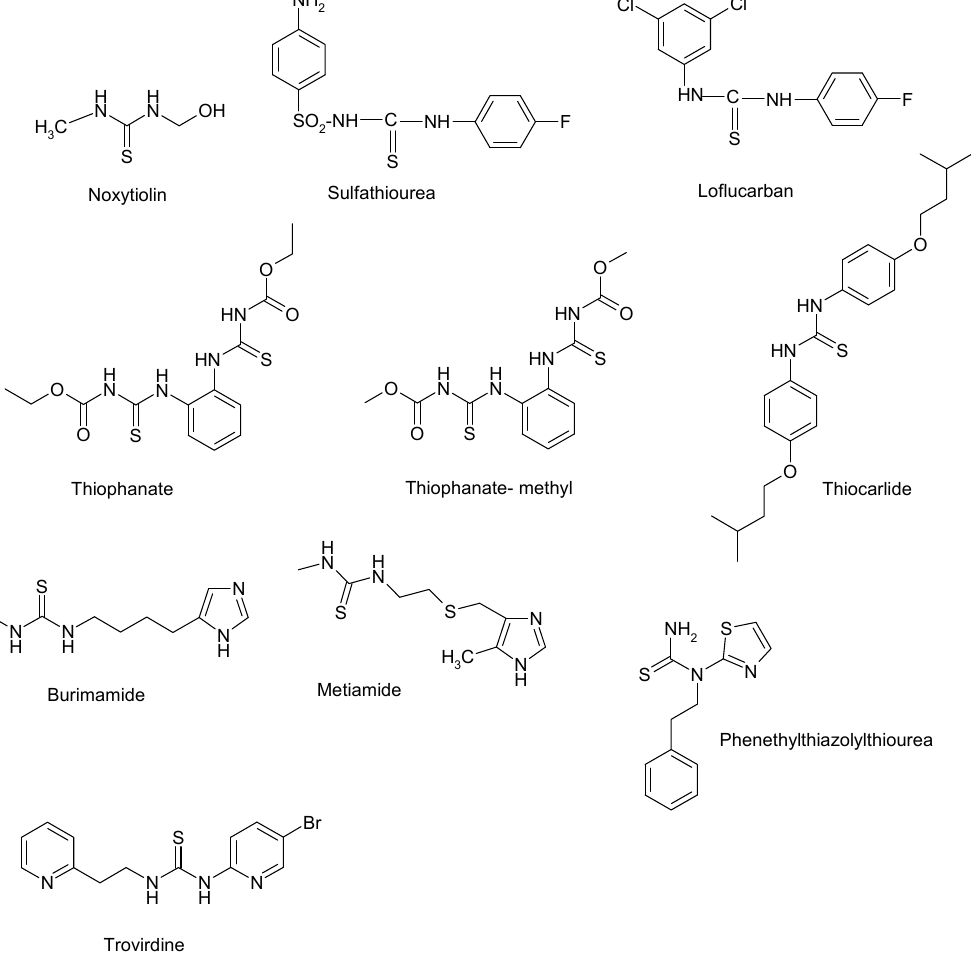
Figure 1. Thiourea derivatives with pharmacological properties. In conclusion, compounds containing the thiourea skeleton in the molecule can be valuable candidates for future chemical modulation in order to achieve different biological actions.